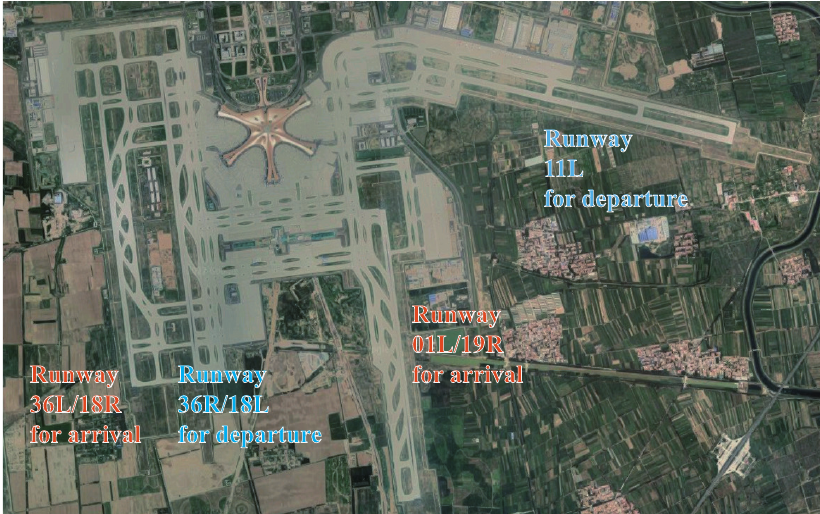
Figure 10. Beijing Daxing International Airport (PKX) runway configuration: runways 36L/18R and 01L/19R marked in red are for arrival only, and runways 36R/18L and 11L marked in blue are for departure only. Runways 01L/19R and 11L are a set of non-intersecting diverging